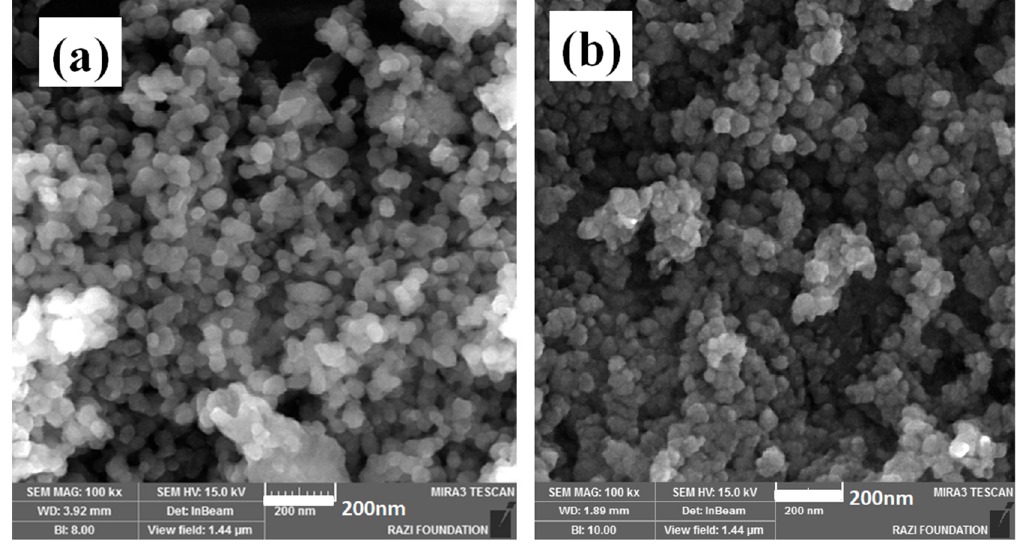
Figure 3. FE-SEM micrographs provided from the ( a ) PEG-MNPs and ( b ) Co 2+ -doped PEG-MNPs surfaces.